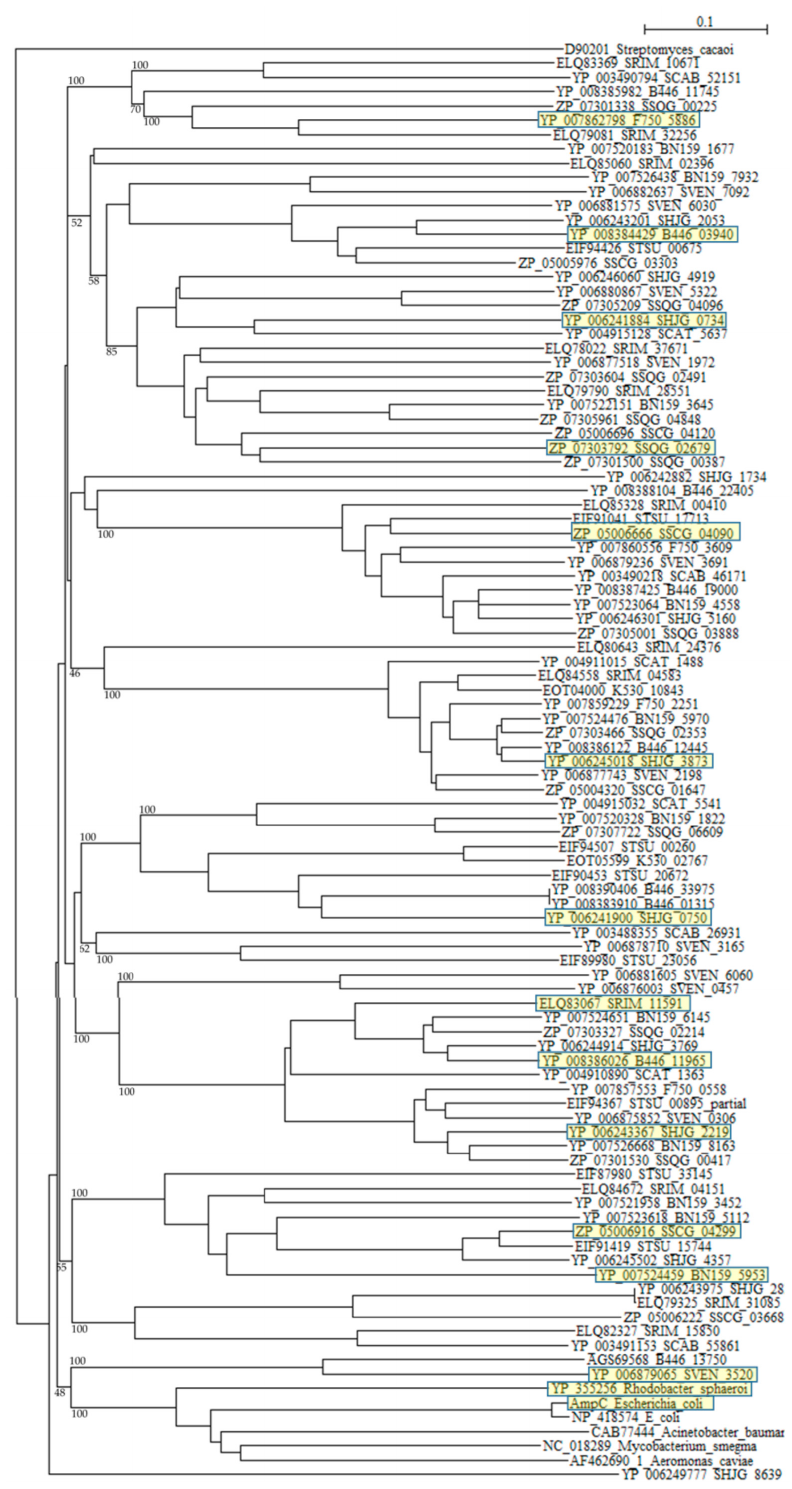
Figure 3. Phylogenetic tree of putative 94 class C β -lactamases on the basis of amino acid sequences. The tree was constructed by using ClustalX 2 [88] and Streptomyces cacaoi class A β -lactamase (D90201) as outgroup. β -lactamases of Rhodobacter sphaeroides (YP_355265), Mycobacterium smegmatis (NC_018289), Acinetobacter baumannii (CAB77444), Aeromonas caviae (AF462690_1), and E. coli (ABM69263 and NP_418574) were used as reference sequences. The sequences marked with yellow boxes were used for the calculation of molecular distances (Table S6). The bootstrap probabilities are shown at branching